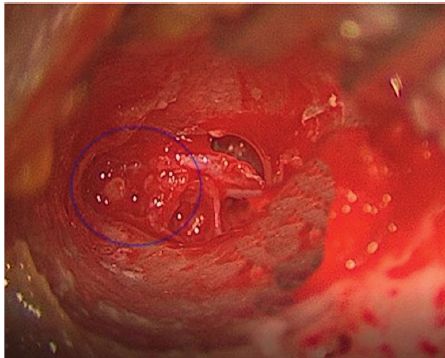
Figure 3: Neuroendocrine adenoma of the middle ear (encircled) during the first surgery; view from the ear canal.